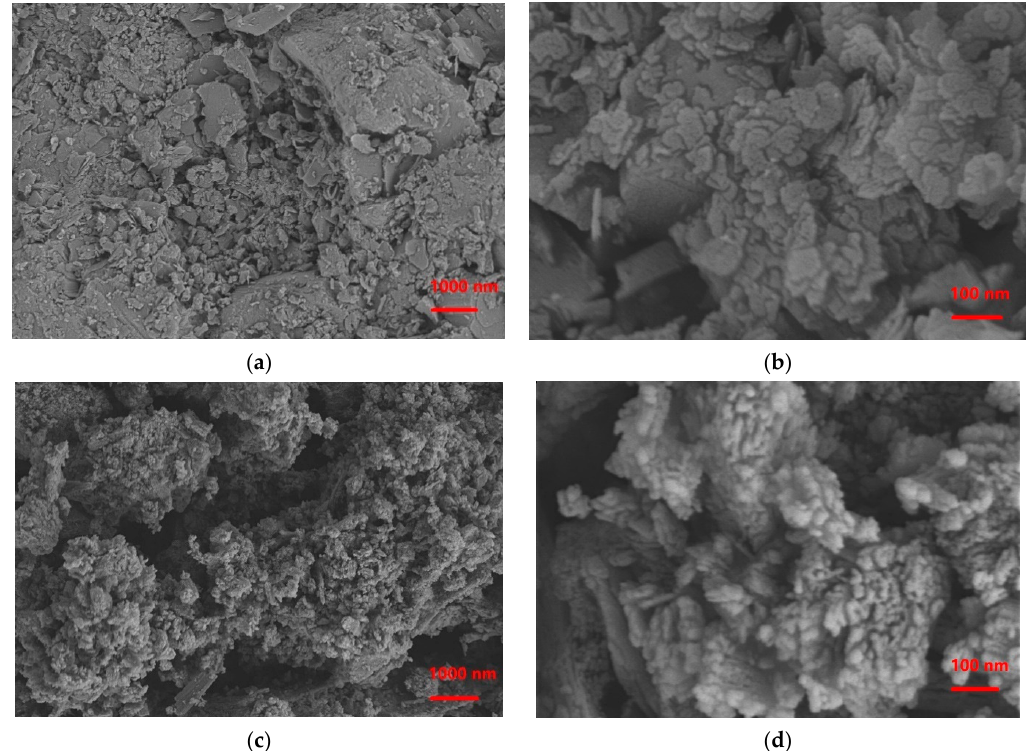
Figure 4. SEM analyses of natural and Mn-Ti modified zeolites: ( a ) and ( b ) are for the natural zeolite, ( c ) and ( d ) are for the Mn-Ti modified zeolite.